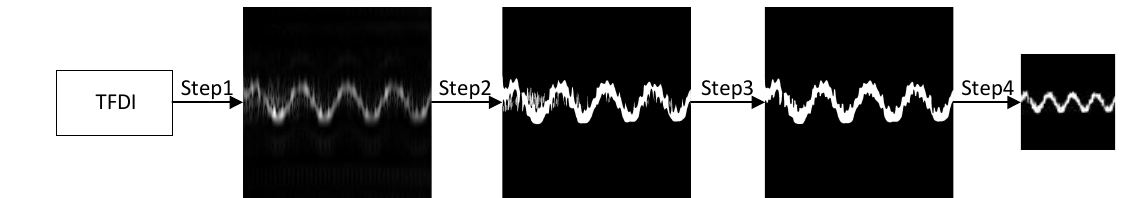
Figure 6. The processes of the TFDI denoising (SFM is selected at –6 dB as an example).